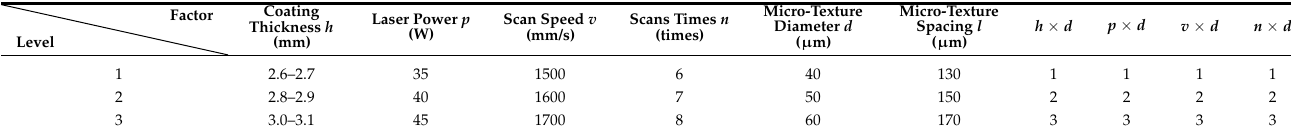
Table 1. Six-factor, three-level interactive experiments.